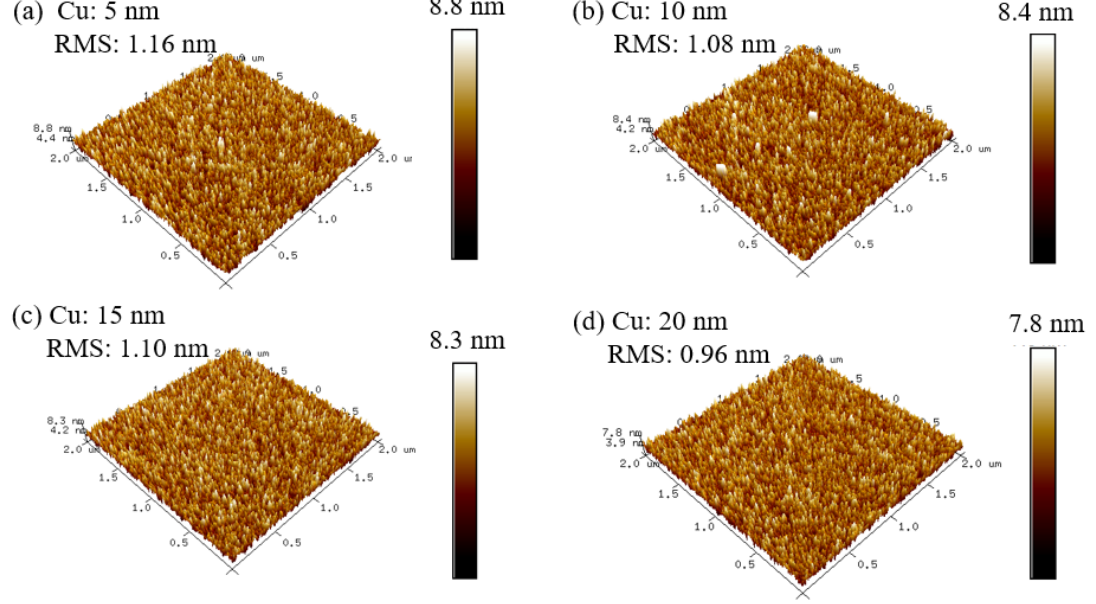
Figure 4. AFM images of ITO/Cu/ITO samples with different Cu interlayer thicknesses: ( a ) 5 nm, ( b ) 10 nm, ( c ) 15 nm and ( d ) 20 nm.